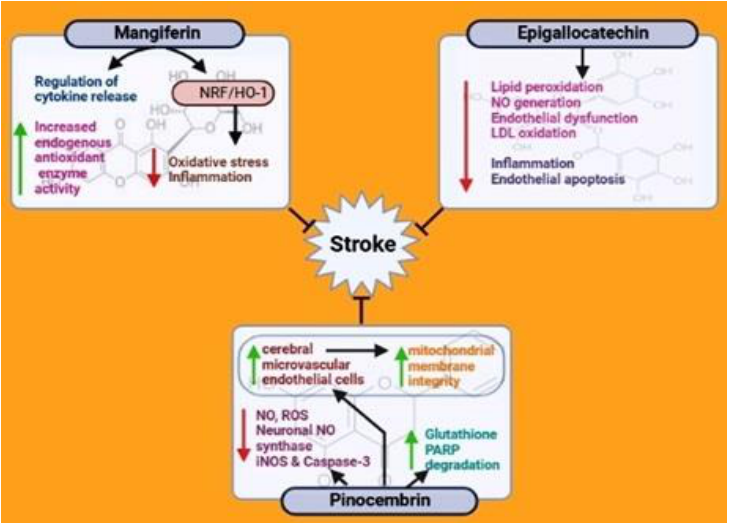
Figure 5. Effects of mangiferin, epigallocatechin, and pinocembrin on stroke.